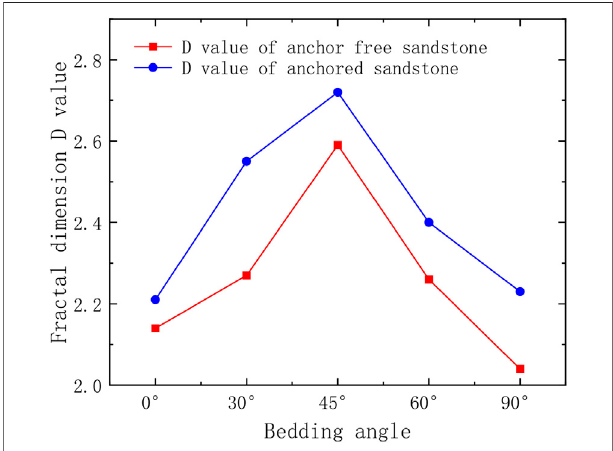
FIGURE 13 | Relationship between D value and bedding angle of anchored and unanchored